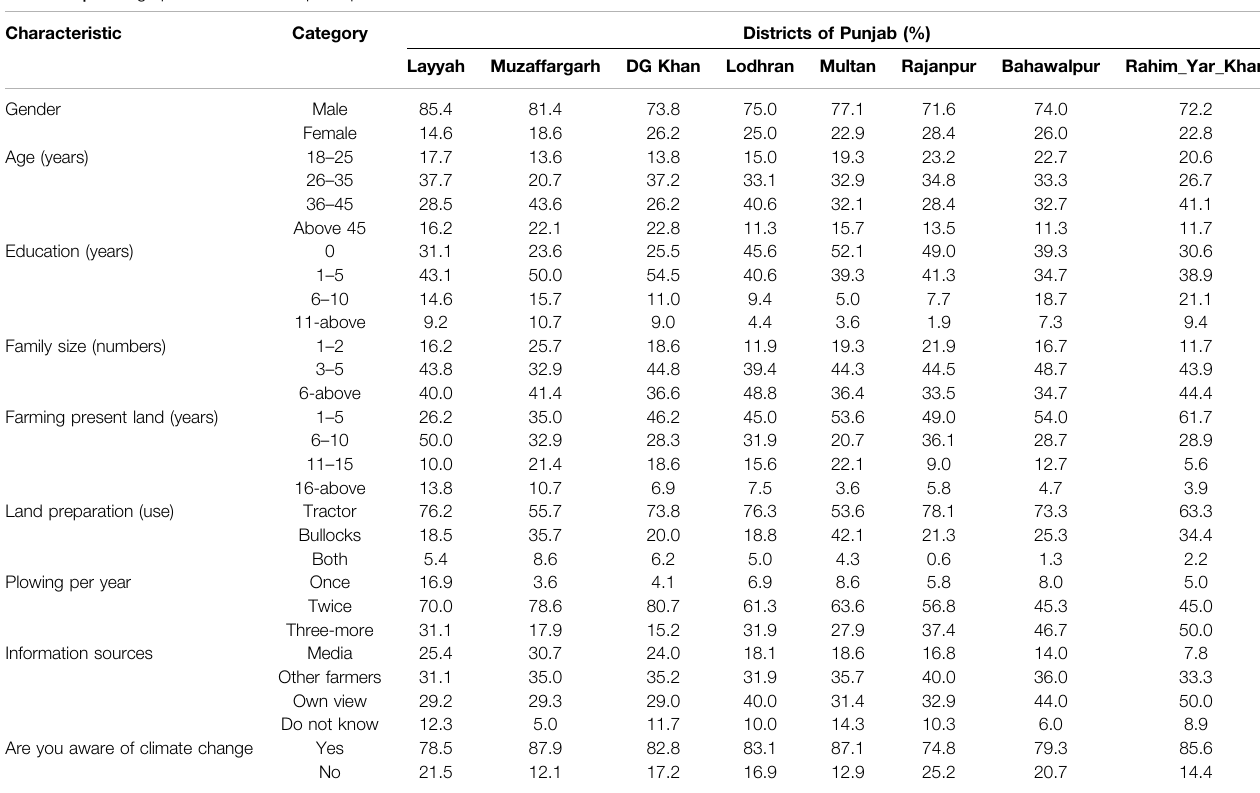
TABLE 2 | Demographic information of participants.